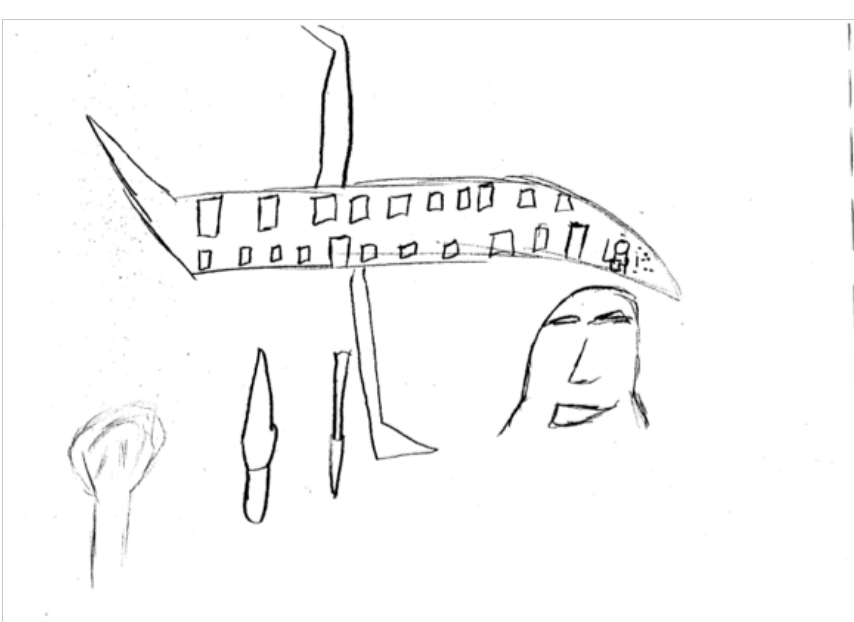
Fig 4. ‘Heathrow’: A twelve year old boy’s map from the exhibition ‘London Before